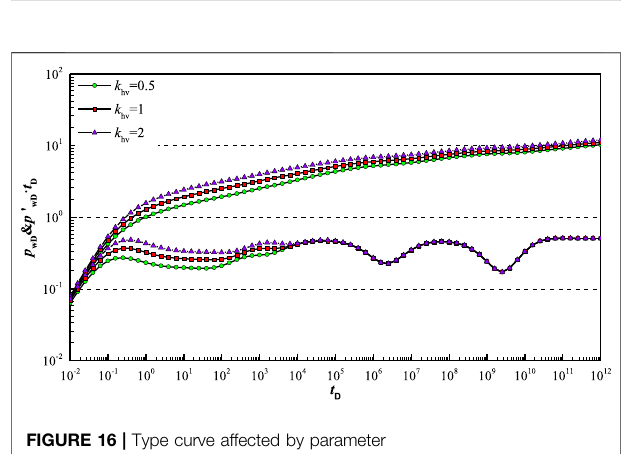
FIGURE 15 | Type curve affected by parameter κ ( λ mf (cid:2) 10 − 12 ) ( C D (cid:2) 0 . 1 , S (cid:2) 0 . 1 , h (cid:2) 100 , h w (cid:2) 200 , r w (cid:2) 0 . 1 , θ w (cid:2) 60 o , k hv (cid:2) 1 , k D (cid:2) 1 , ω f (cid:2) 0 . 01 , ω